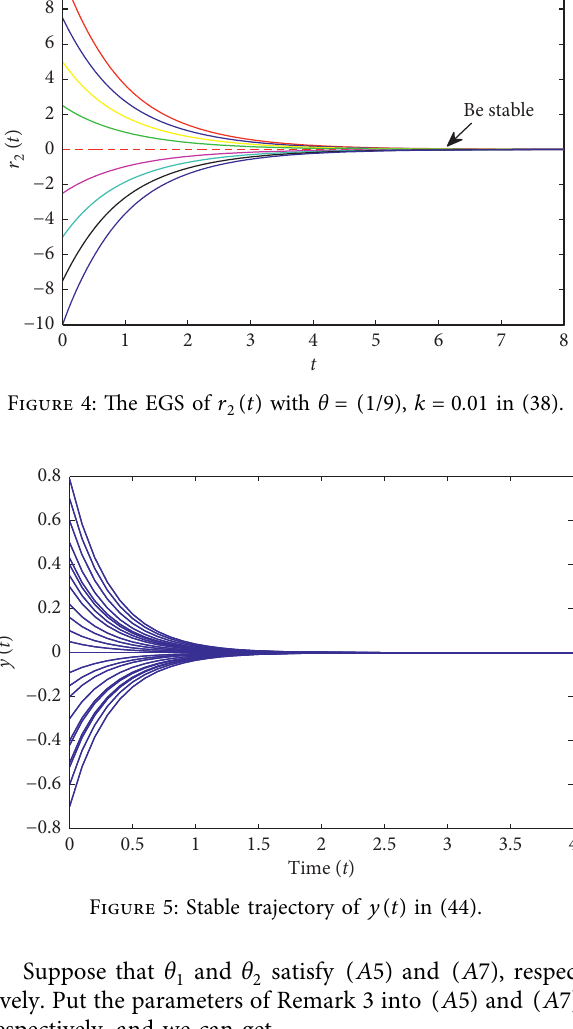
Figure 5: Stable trajectory of y ( t ) in